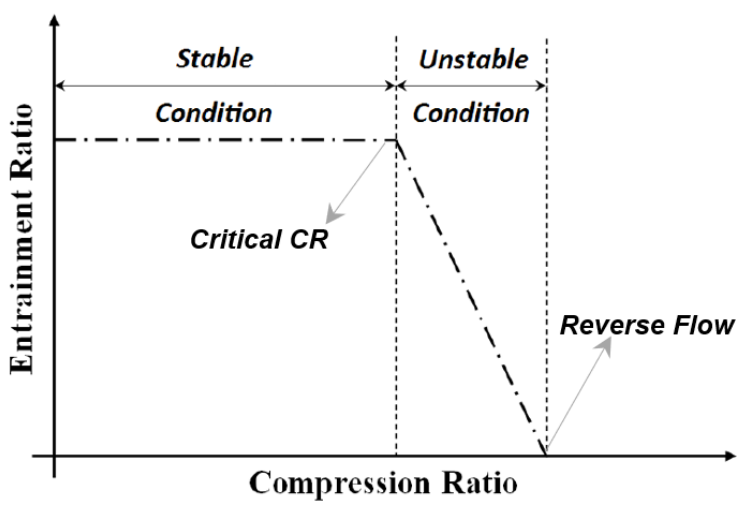
Figure 5. Ejector performance curve.